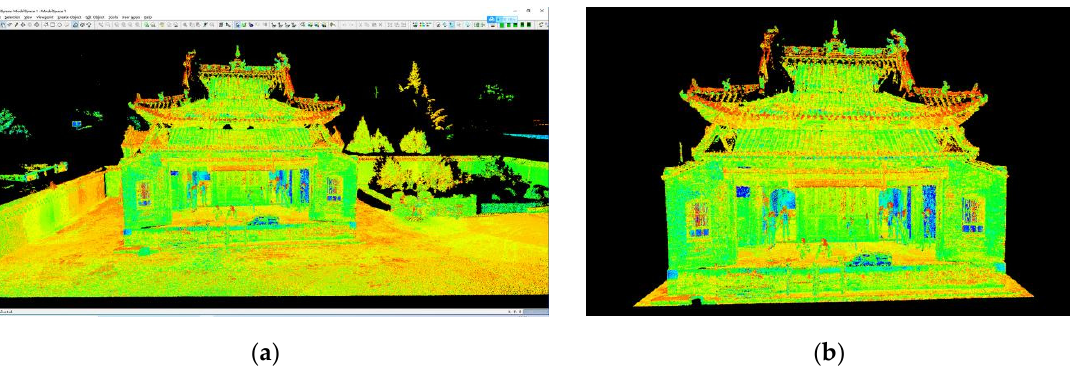
Figure 5. Point cloud. ( a ) Original point cloud. ( b ) Preprocessed point cloud. Images were also divided into two types. One was a .raw file, which recorded the metadata of original information, including the ISO setting, shutter speed, aperture value, white balance, etc.